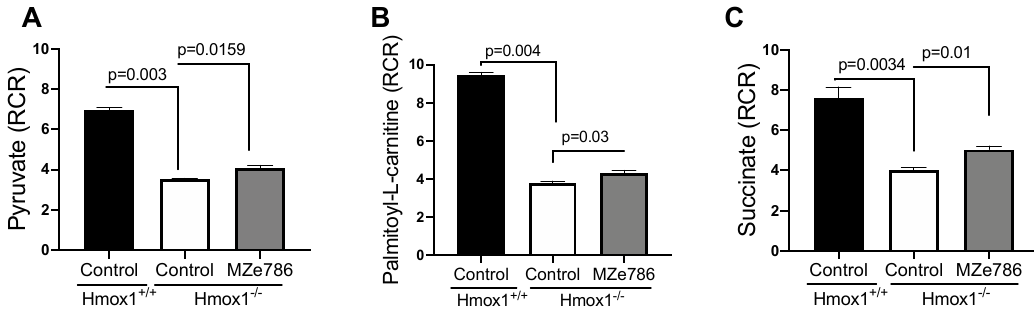
Figure 1. Loss of HO-1 disturb the cardiac mitochondrial respiration. Mitochondrial oxygen consumption was measured in isolated cardiac mitochondria from Hmox1 +/+ and Hmox1 − / − mice exposed to MZe786 via gavage. The respiratory control ratio (RCR) (state 3 / state 4o) was calculated using complex I-driven substrates: ( A ) pyruvate and ( B ) palmitoyl-L-carnitine. ( C ) RCR was calculated in complex II-stimulated cardiac mitochondria using succinate as substrate. Values are expressed as means ± SEM. N = 4.